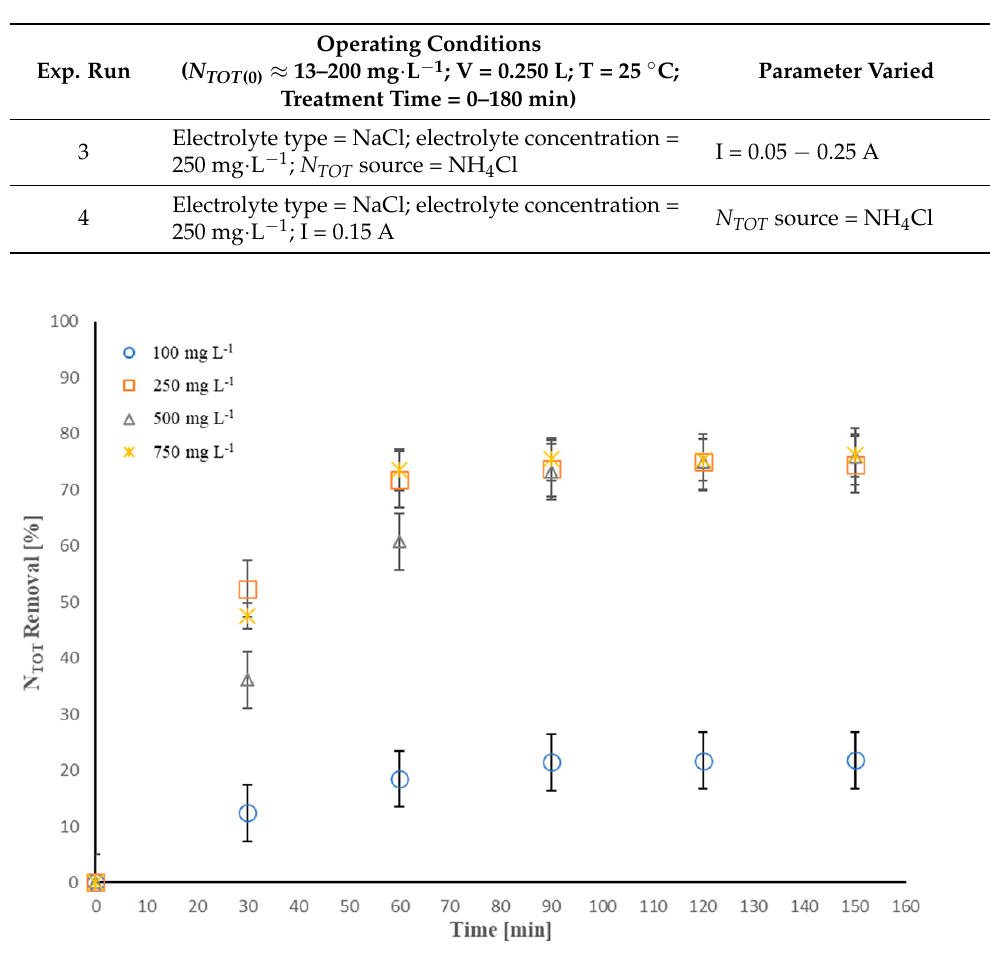
Figure 2. Effect of chloride concentration on N TOT removal (%): I = 0.15 A, electrolyte composition =